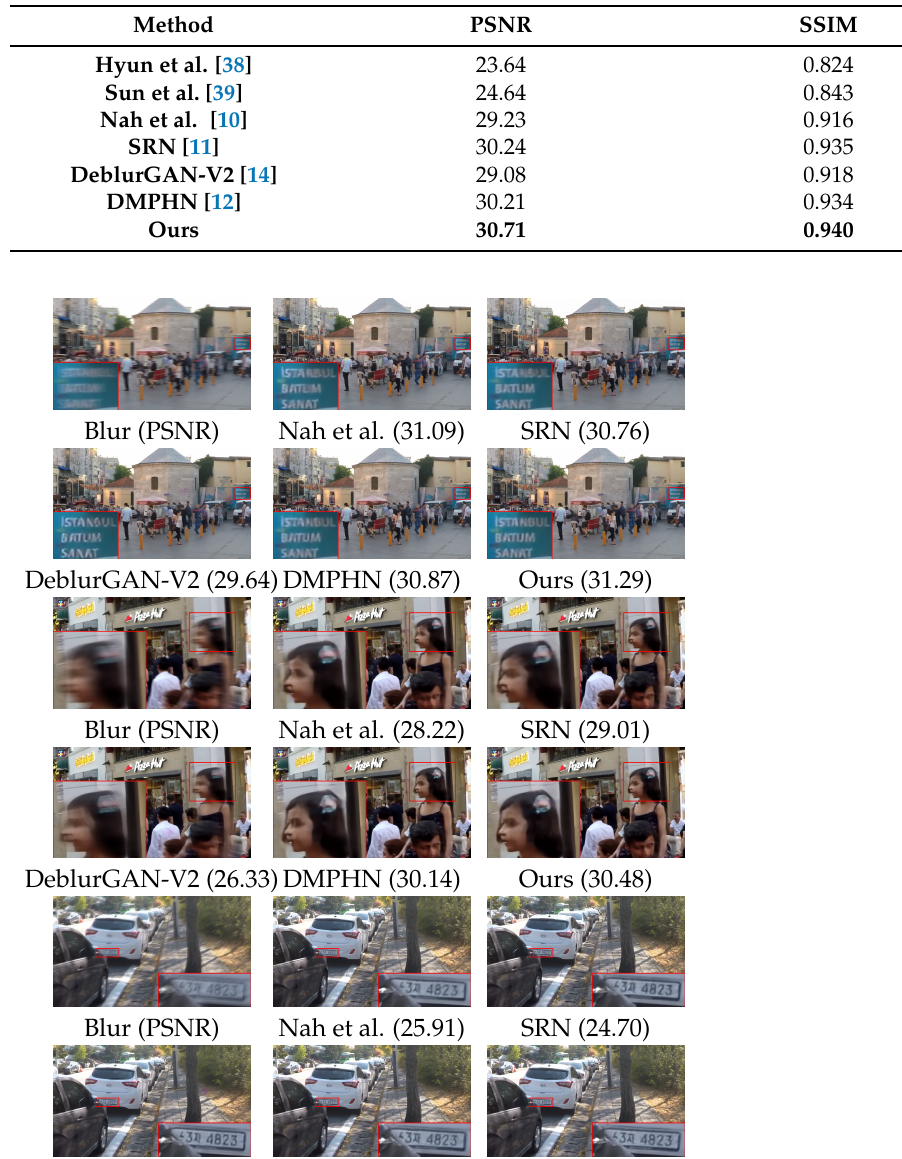
Table 2. The average PSNR and SSIM on the GOPRO test dataset.